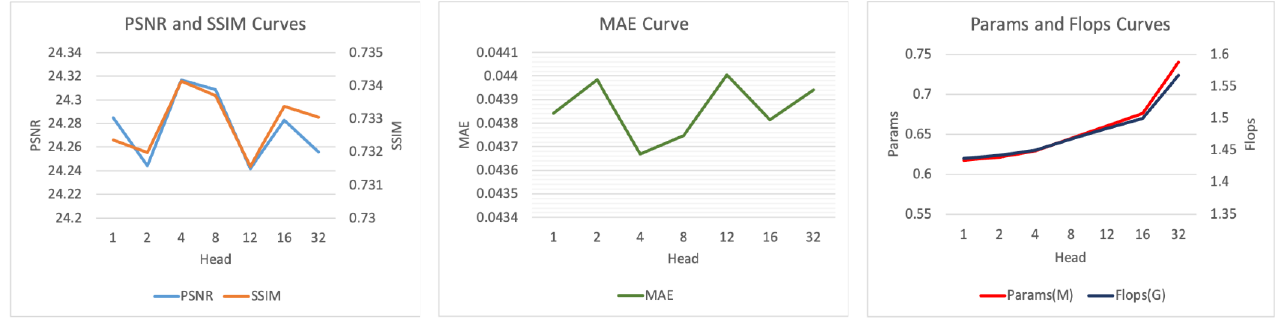
Figure 11. Performance curves of different head numbers on the AID dataset. Higher PSNR and SSIM values denote a better performance. Lower MAE values denote a better